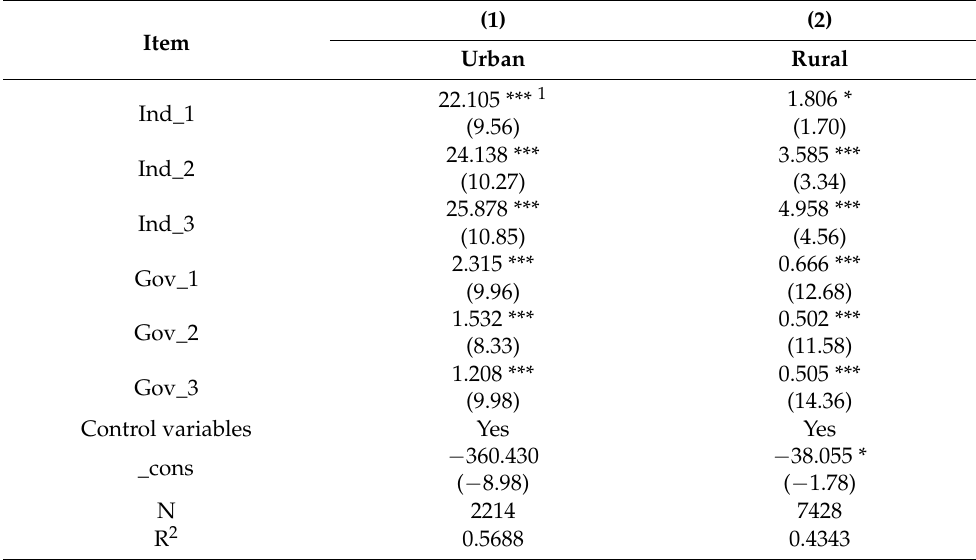
Table 9. Results of panel threshold estimation of grouped sample of urban and rural